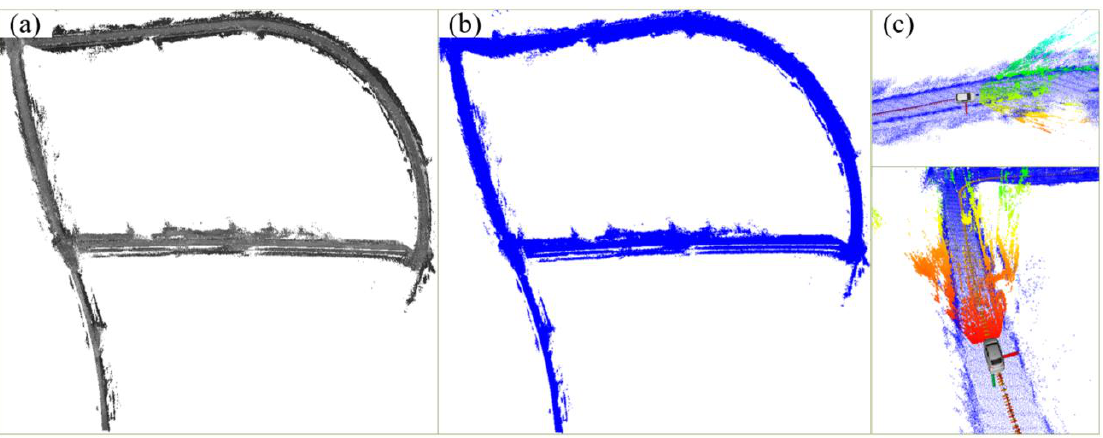
Figure 7. Localization process of different stages by the proposed method with the field test data Site-2. ( a ) Dense prior visual point cloud map; ( b ) priori visual point cloud map after downsampling; ( c ) local enlargement of localization result.